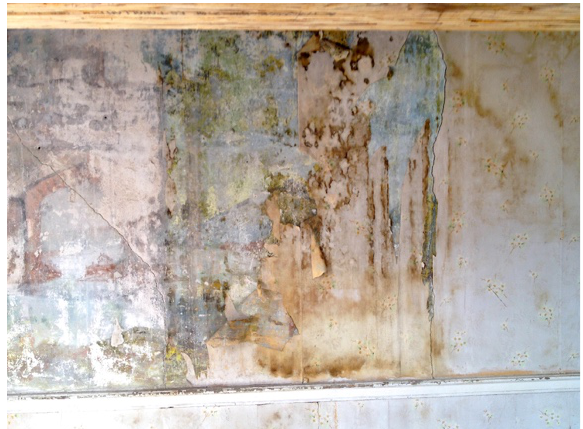
Figure 5: North wall paintings and wallpaper after roof leak. Source: Ann